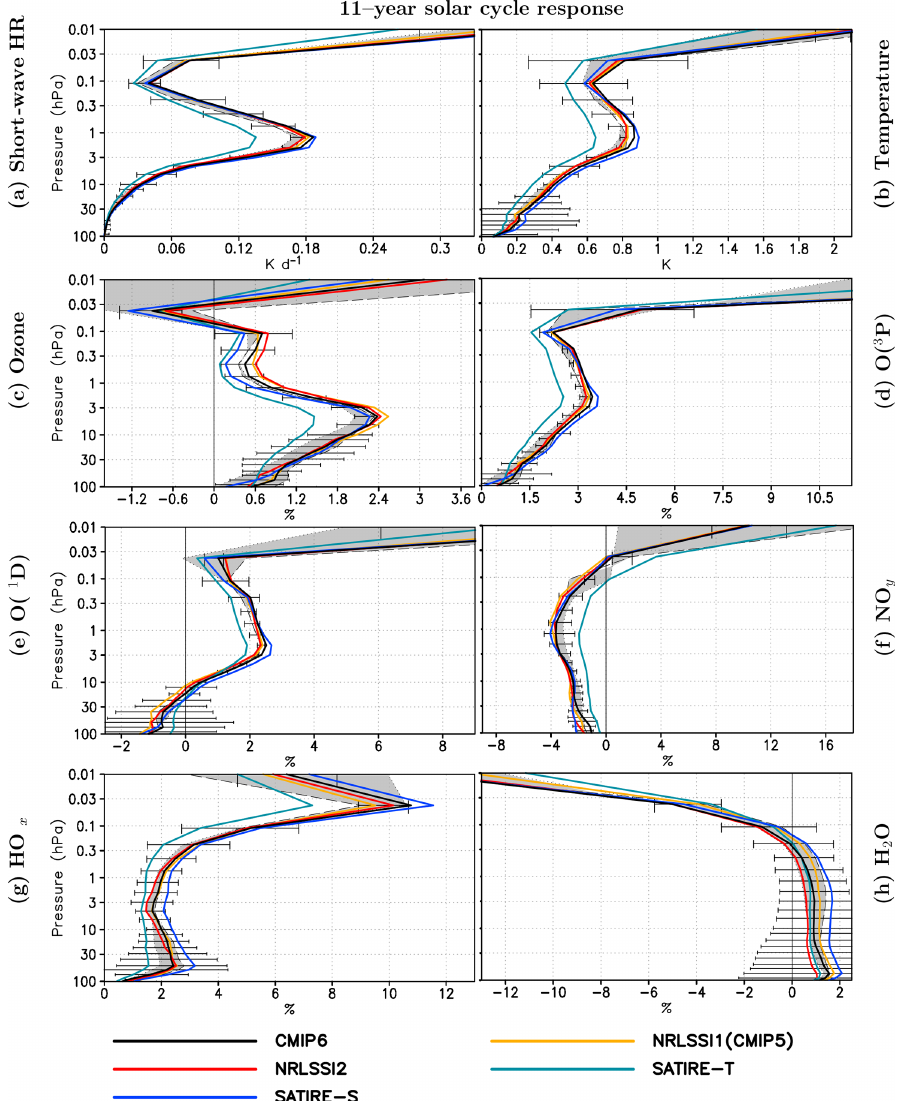
Figure 5. Annual mean 11-year solar cycle response (60 ◦ S–60 ◦ N) in (a) SW heating rates, (b) temperature, (c) ozone concentrations, (d) atomic oxygen (O ( 3 P ) ), (e) atomic oxygen (O ( 1 D ) ), (f) NO y , (g) HO x , and (h) H 2 O. Solar responses are derived for an average of WACCM and EMAC simulations using five SSI data sets at solar maximum, NRLSSI1(CMIP5) (yellow), NRLSSI2 (red), SATIRE-S (blue), SATIRE-T (dark blue), and CMIP6 (black), relative to the average of the WACCM and EMAC reference solar minimum simulations. The shaded area indicates the range of the WACCM (black long dash contour) and EMAC (black dotted contour) ensemble means. The 95% uncertainty error bar is given for the averaged solar response over the complete ensemble, calculated with Student’s t